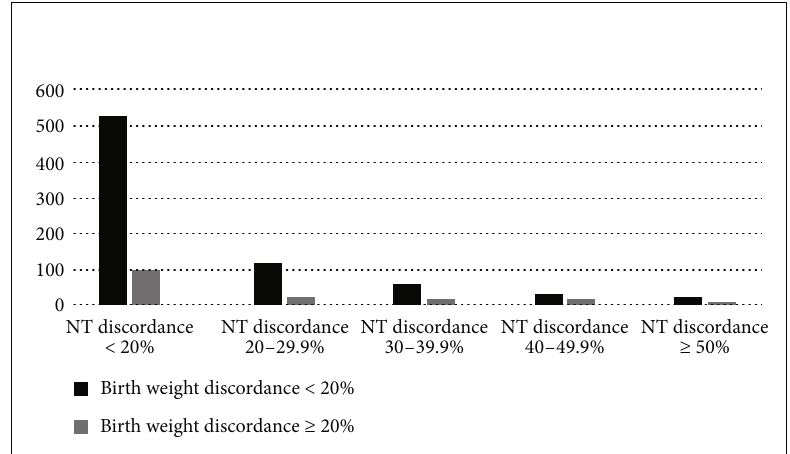
Figure 1: Nuchal translucency and birth weight discordance distribution.